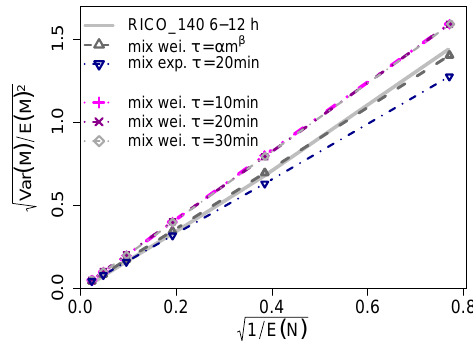
Figure 12. Comparison of the distribution pairs from the simula- tions using a constant and the mass-flux-dependent cloud